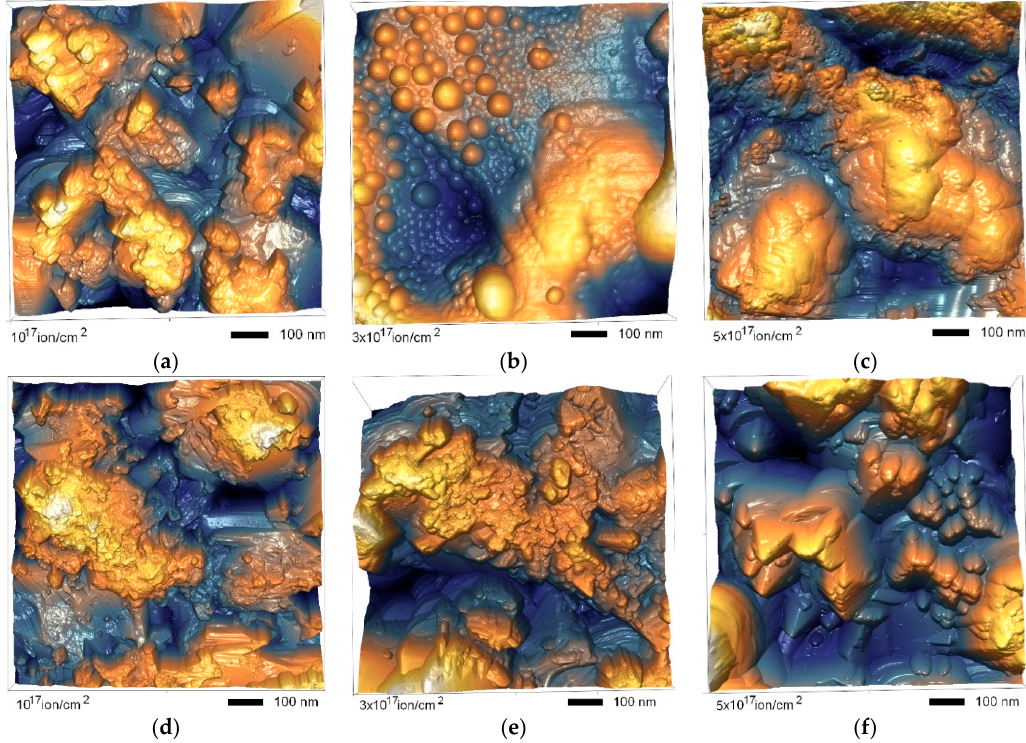
Figure 2. AFM images of studied ceramics after irradiation. ( a ) 10 17 ion/cm 2 , 300 K; ( b ) 3 x 10 17 ion/cm 2 , 300 K; ( c ) 5 x 10 17 ion/cm 2 , 300 K ; ( d ) 10 17 ion/cm 2 , 1000 K; ( e ) 3 x 10 17 ion/cm 2 , 1000 K; ( f ) 5 x 10 17 ion/cm 2 , 1000 K.